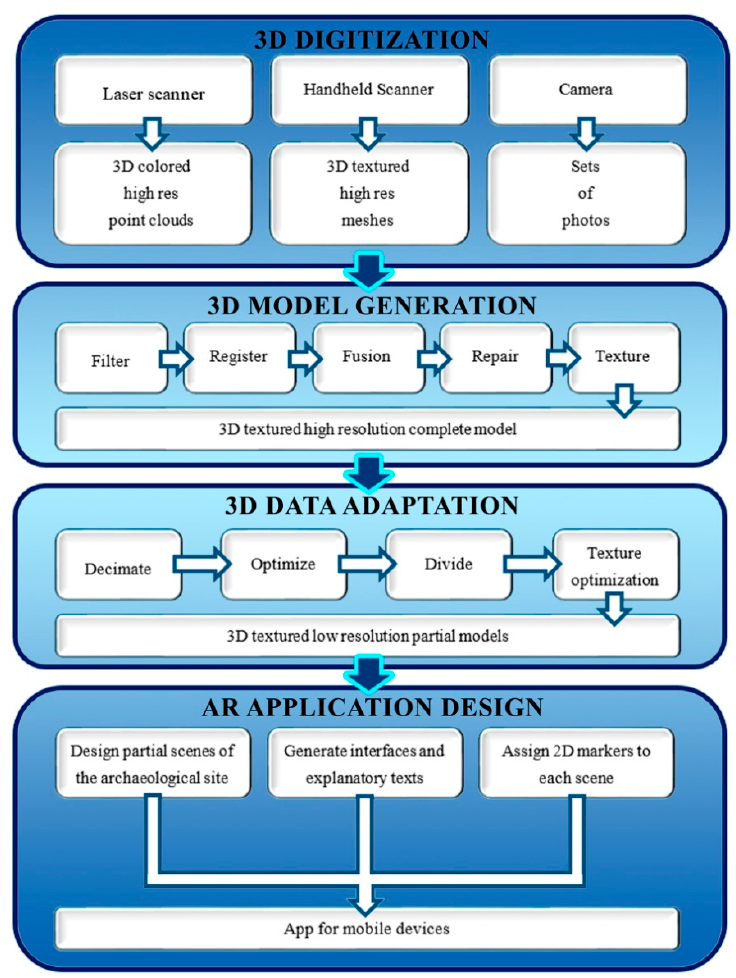
Figure 6. Scheme of the procedure to produce the proof of concept of the AR application.